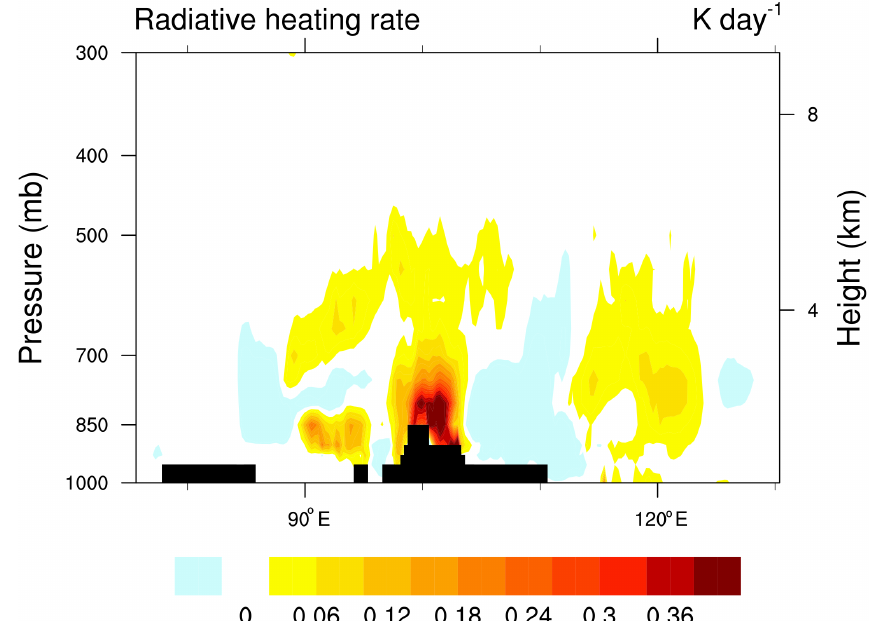
Figure 16. Cross section of the dust-induced radiative heating rate (K × d − 1 ) from 15 to 45 ◦ N during the simulation period from the WRF-Chem